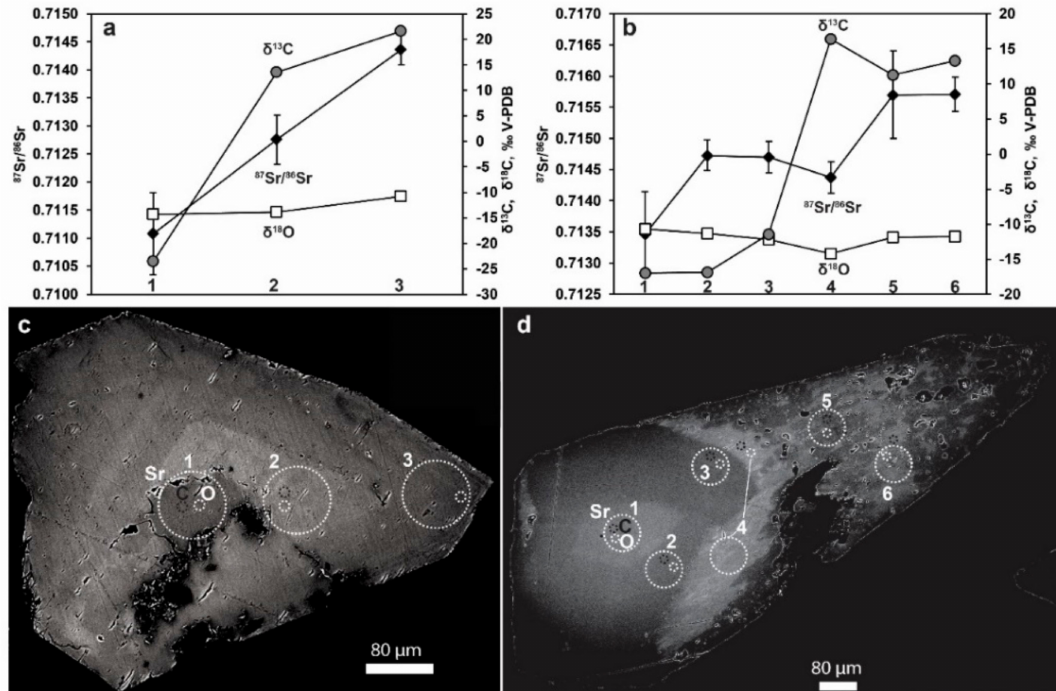
Figure 5. 87 Sr / 86 Sr values in transects of fracture coating calcite from Forsmark ( a , b ) with spot locations (also for previously reported C and O isotope values [34]) marked on back-scattered SEM-images of polished crystal cross-sections, showing clear growth zonation (( c ) corresponds to ( a ), ( d ) to ( b